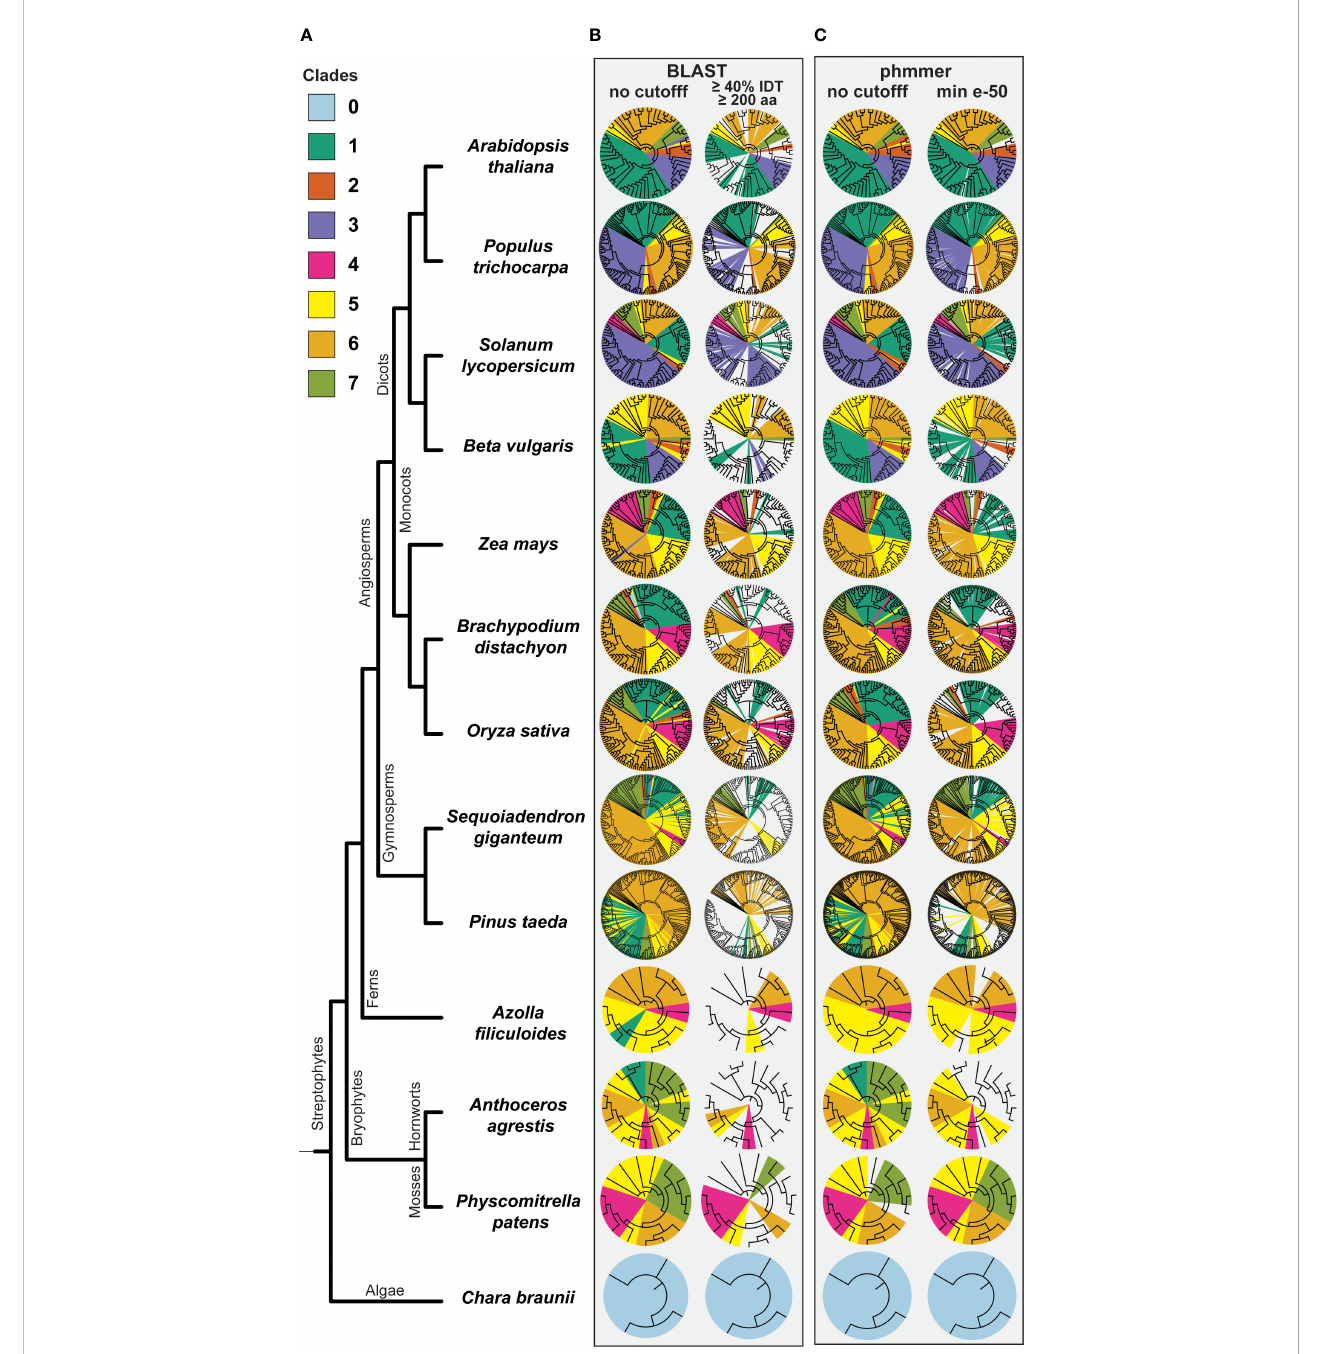
FIGURE 2 Phylogenetic distribution of BAHD clades in selected plant species. (A) Representative species were selected from early diverging plant lineages, gymnosperms, monocots, and dicots. Clade colors correspond to previously published clade assigne-ments of characterized BAHD members (Kruse et al, 2022). BAHD sequences were assigned to clades using (B) blastp with either no cutoff or a 40% IDT, 200 aa match length cutoff and (C) using the software phmmer with no cutoff or a minimum e-value of e-50. Each phylogenetic tree was inferred using IQTree with 1000 non- parametric bootstrap replicates, illustrated in iTOL (Letunic and Bork, 2021) and mapped clades were indicated using different